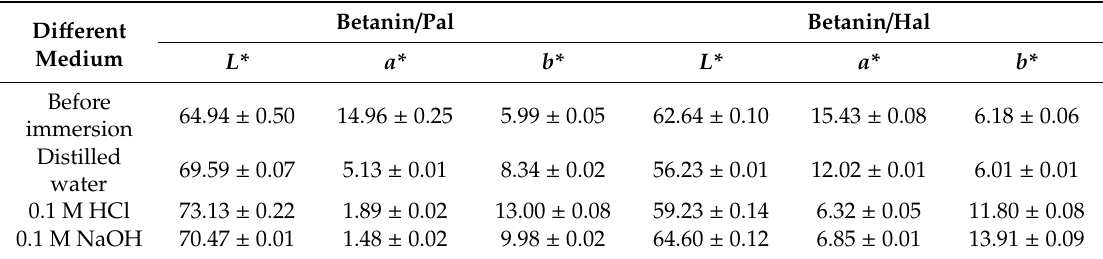
Table 2. Color parameters of betanin / Pal and betanin / Hal before and after being treated by distilled water, 0.1 M HCl and 0.1 M NaOH for 24 h.